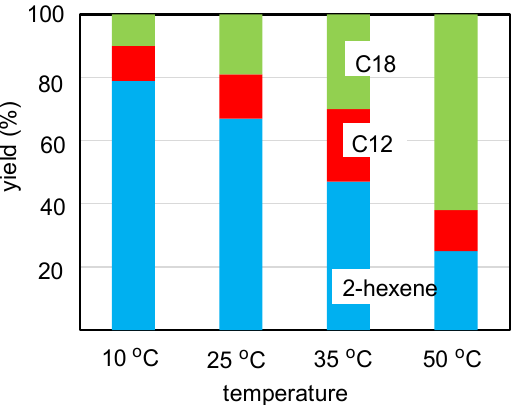
Figure 5. Temperature effect of oligomerization of 1-hexene. 1-Hexene: 3.0 mmol, Ni: 0.010 mol, [Al]/[Ni] = 300, toluene 10 mL, 24 h. Conversion of 1-hexene is 83–95% for the reactions.